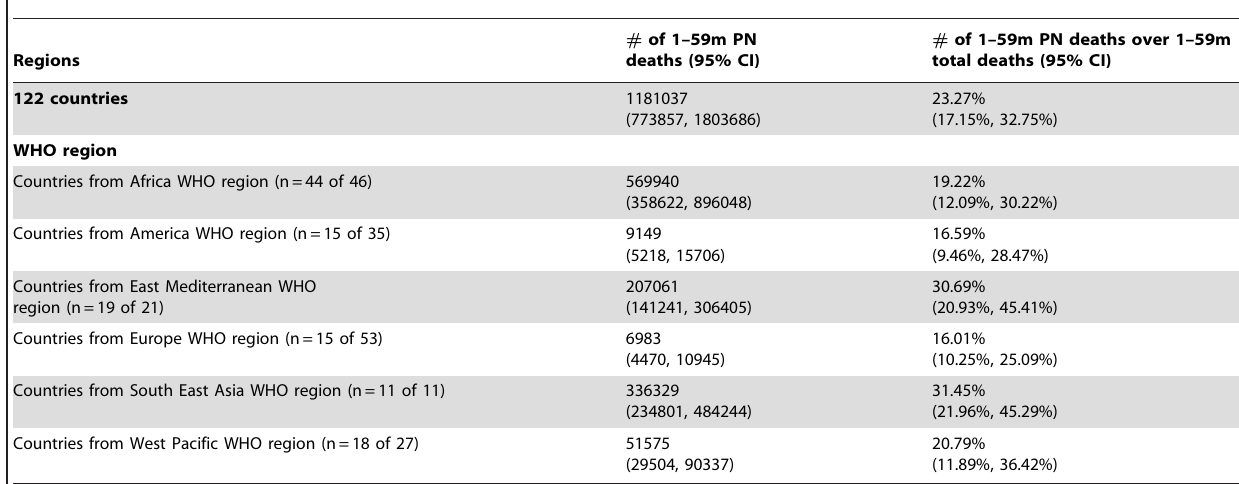
Table 3. Post-neonatal pneumonia number of deaths and mortality rates for the WHO regions (PN: Pneumonia; 95% CI: 95% Confidence Interval; WHO: World Health